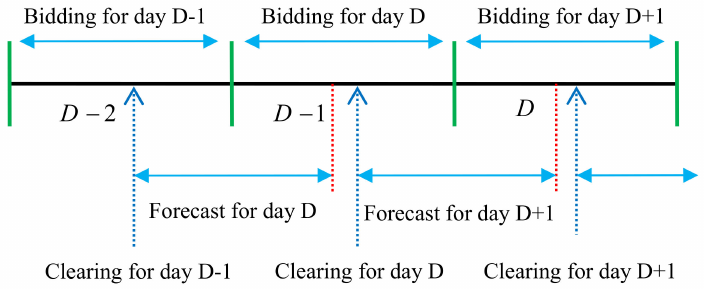
Figure 6. Proposed time framework for day-ahead electricity price